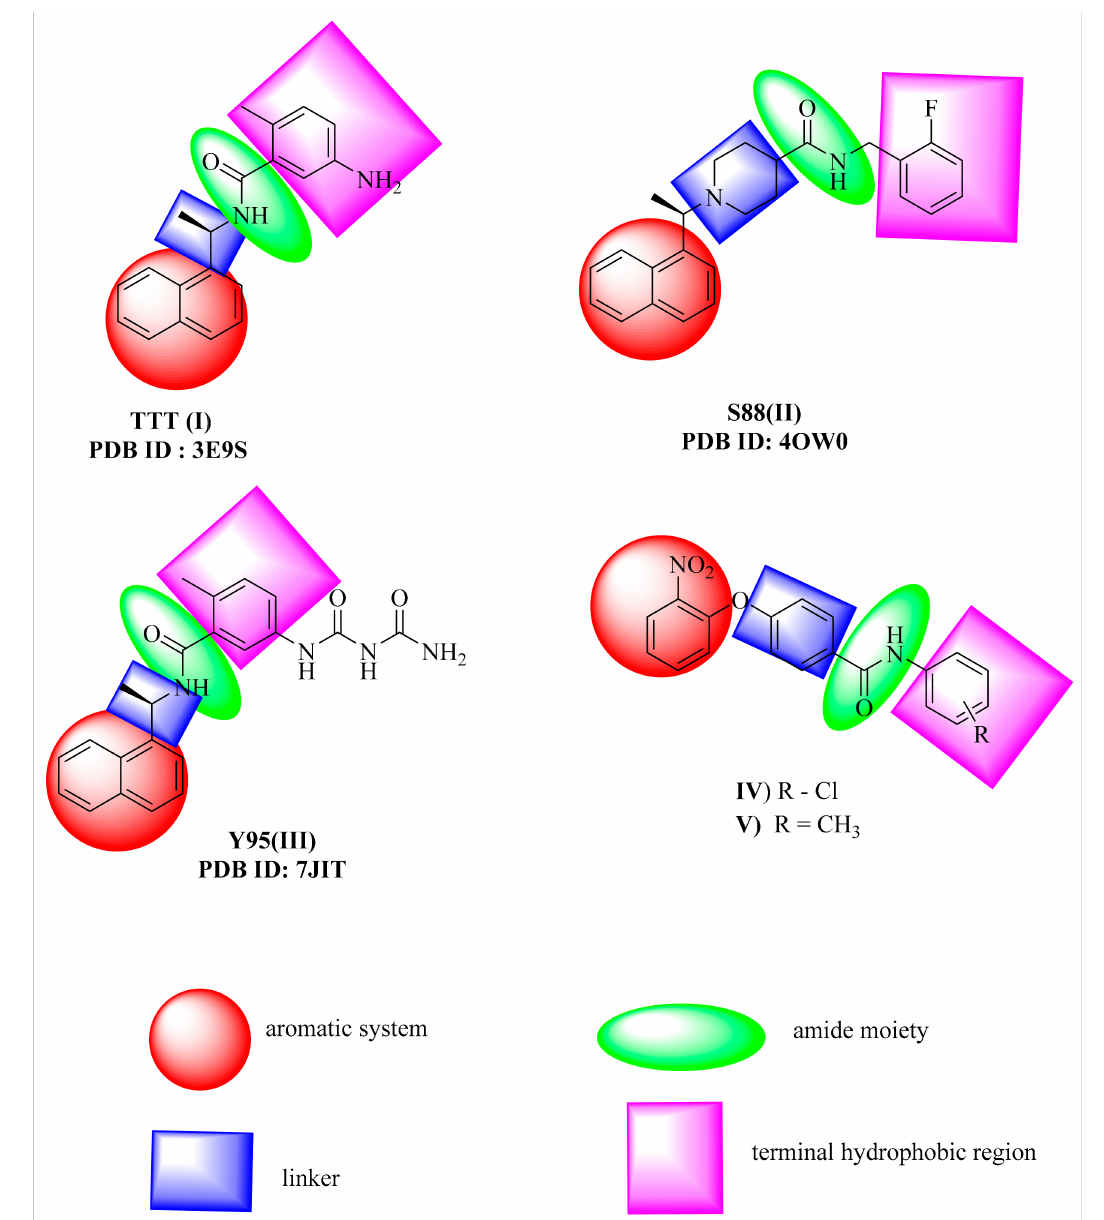
Figure 1. Essential pharmacophoric features of SARS-CoV-2